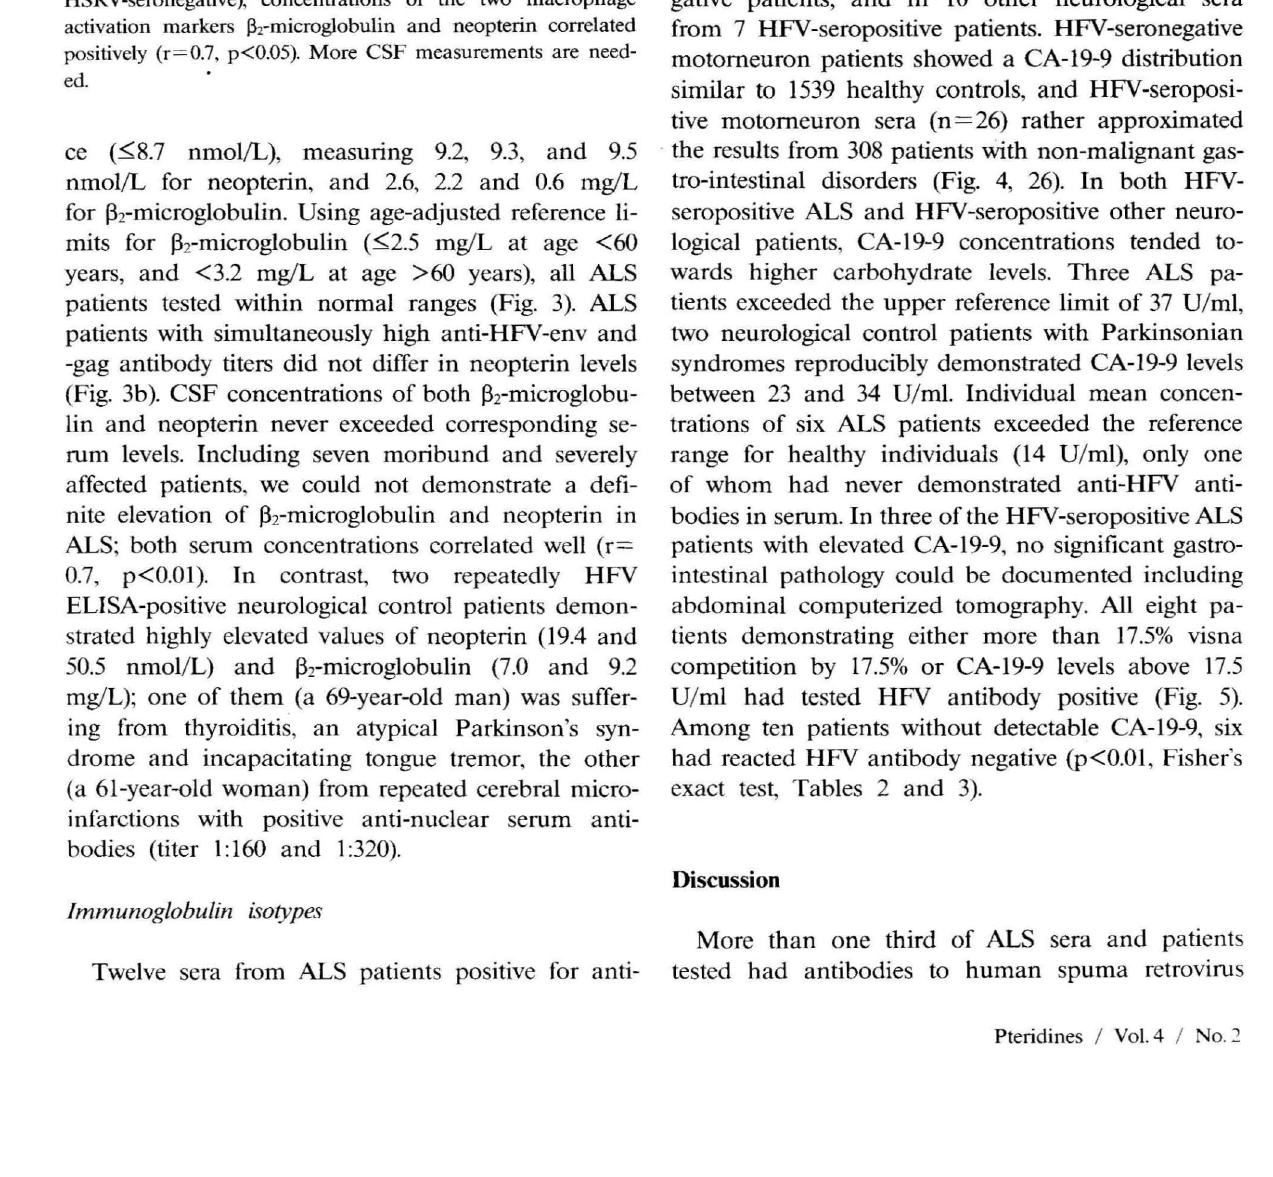
Figure 3. Serum t'h-microglobulin and neopterin in 55 ALS sera: In 55 sera from 28 ALS-patients (14 HFY-seropositive, 14 HSRV-seronegative), concentrations of the two macrophage activation markers 13r microglobulin and neopterin correlated positively (r=0.7, p<0.05). More CSF measurements are need